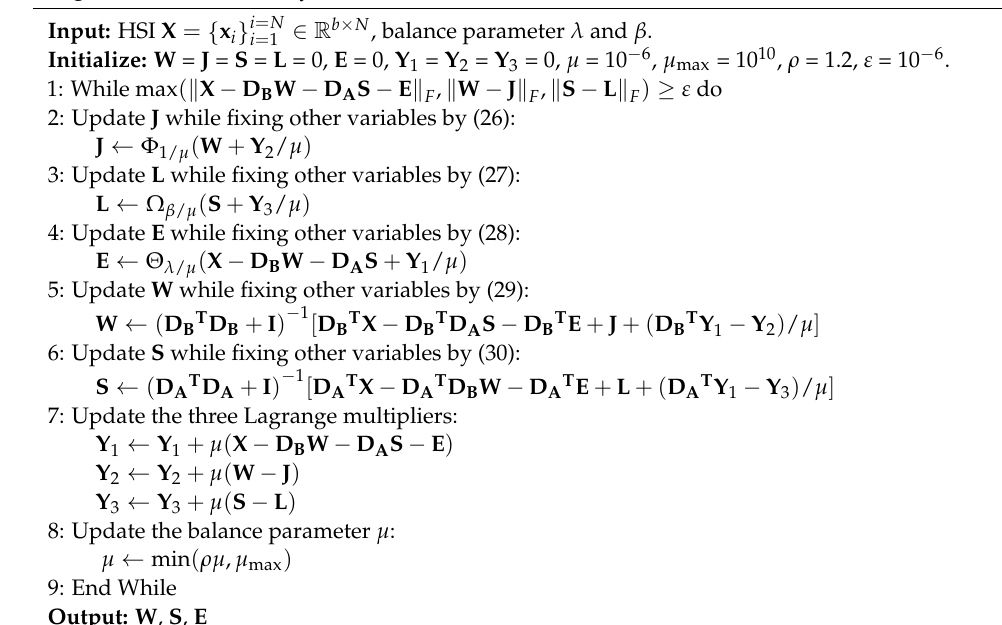
Algorithm 1. Solve (25) by ADMM.